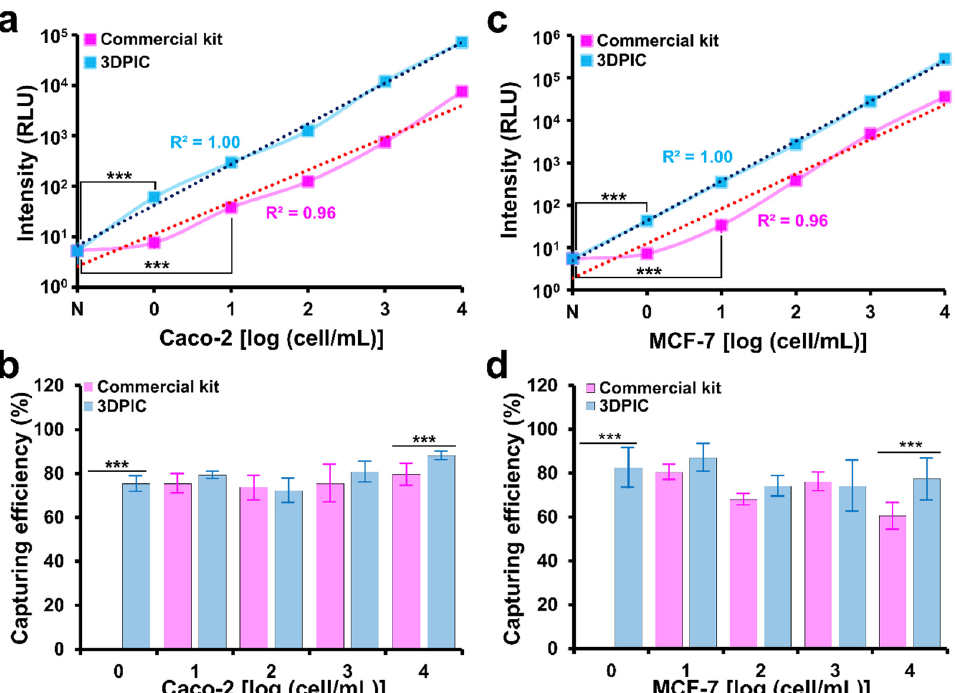
Figure 4. Comparison between 3DPIC and a commercial cell separation kit for cancer cell isolation. Number ( a , c ) and capturing efficiency ( b , d ) of Caco-2 ( a , b ) and MCF-7 ( c , d ) cells at different con- centrations (1–10 4 cells/mL, final conc.) isolated by the commercial kit and 3DPIC using the ATP luminescence assay. Student’s t -test, *** p < 0.001, n = 3.